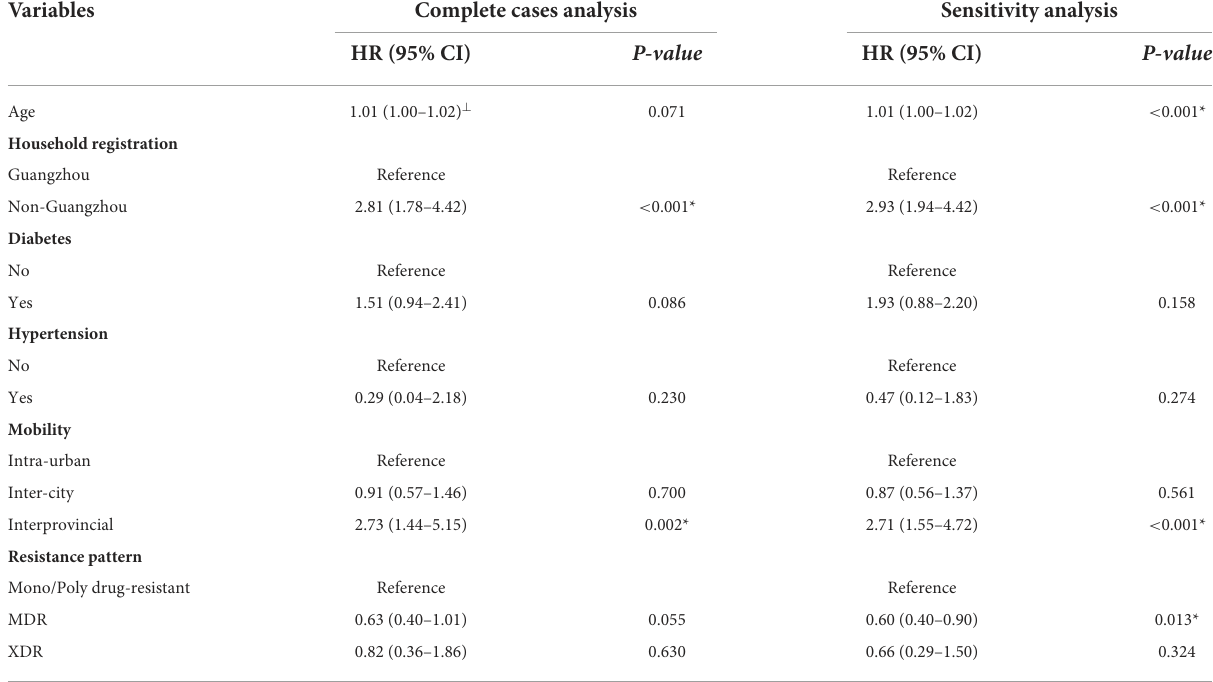
TABLE 4 Factors associated with LTFU (i.e., loss to follow-up) in patients with drug-resistant tuberculosis in Guangzhou, China, from 2016 to 2020 in complete case analysis and sensitivity analysis after multiple